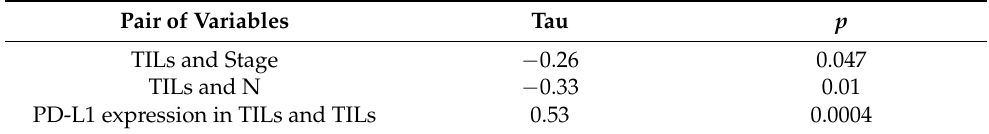
Table 9. Correlations between TILs, investigated molecules, and clinicopathological parameters of patients.